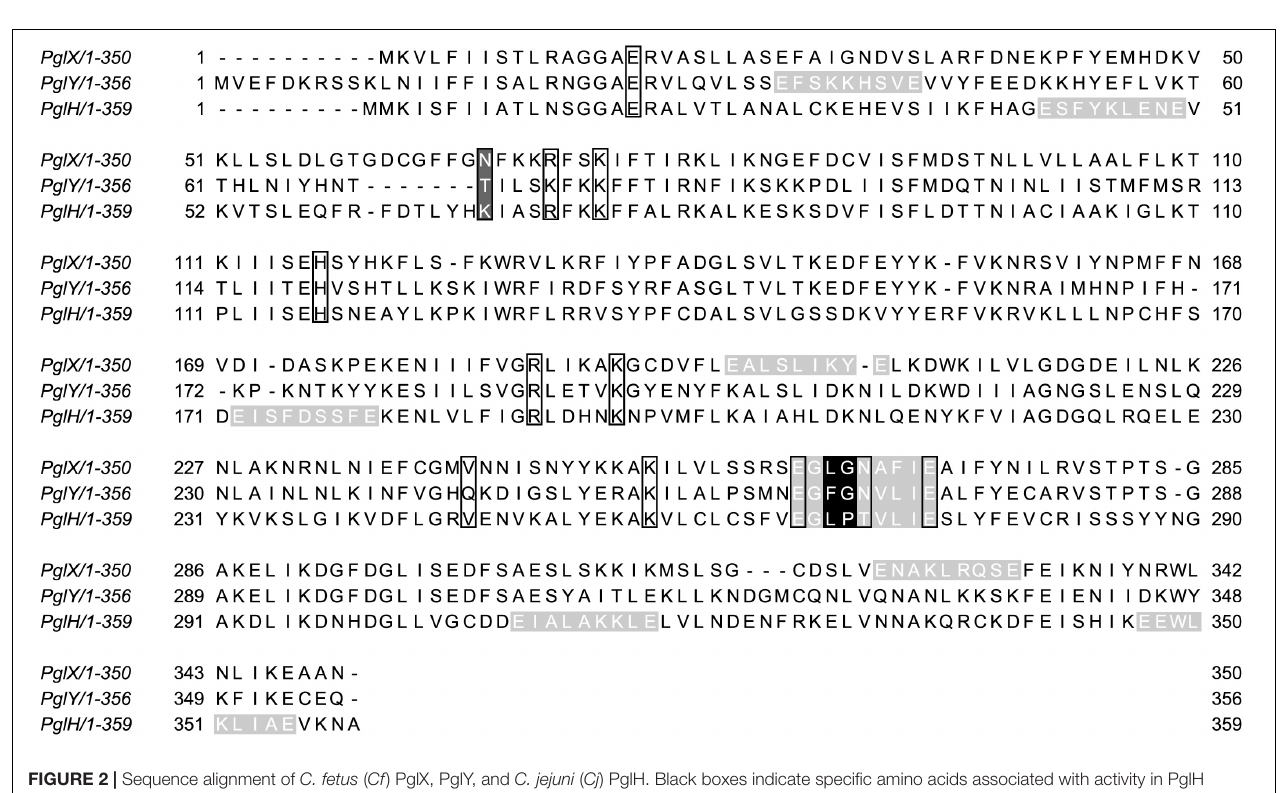
FIGURE 2 | Sequence alignment of C. fetus ( Cf ) PglX, PglY, and C. jejuni ( Cj ) PglH. Black boxes indicate specific amino acids associated with activity in PglH (Troutman and Imperiali, 2009; Ramirez et al., 2018). Black and dark gray amino acids represent functional residues that show non-conserved substitutions in PglX and PglY. Light gray highlighted sequences indicate EX 7 E motifs commonly found in glycosyltransferases (Cid et al., 2000; Coutinho et al., 2003; Troutman and Imperiali, 2009). The catalytic EX 7 E motif of Cj -PglH is located at residues E266 to E274. Cf -PglX CFF8240_1386, Cf -PglY CFF8240_1385, and Cj DDV78_00080 sequences were analyzed by Jalview (Waterhouse et al.,